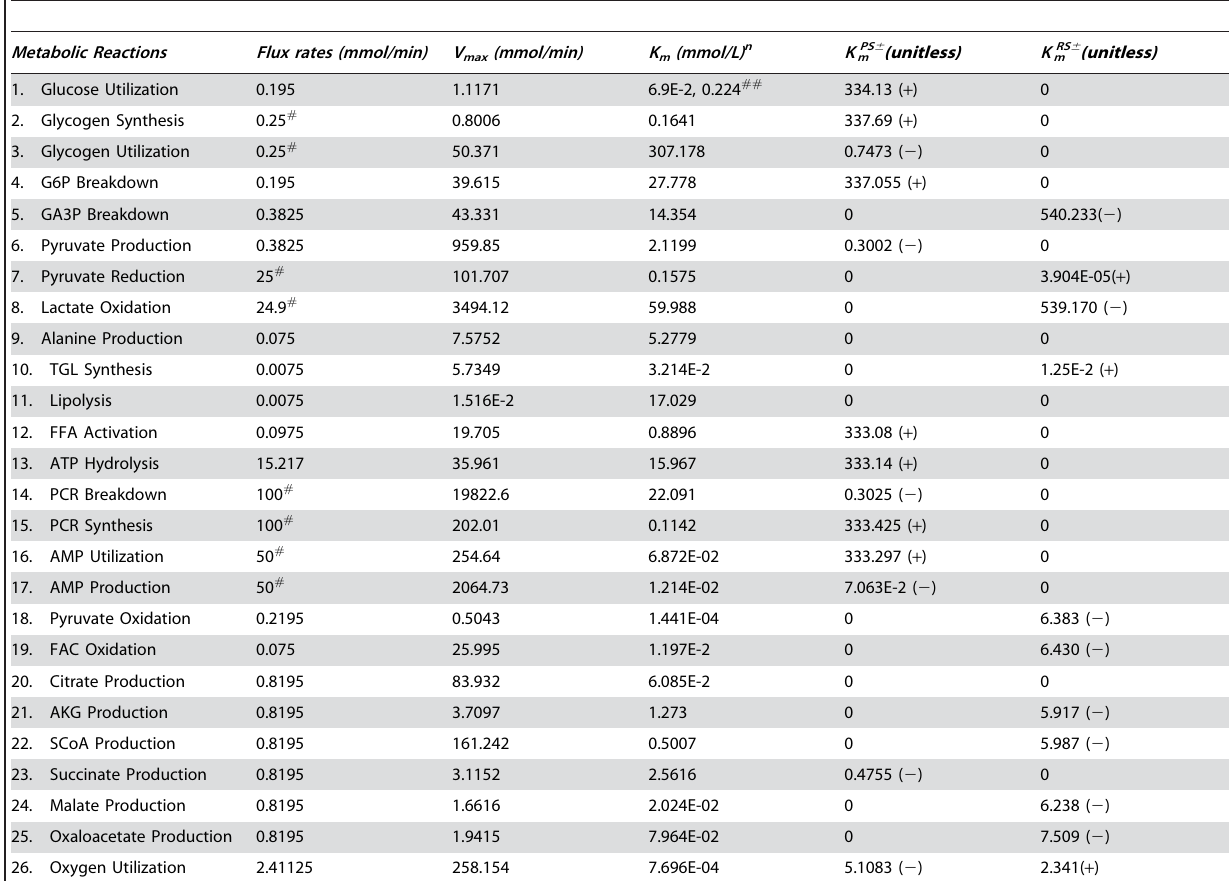
Table 4. Resting, steady-state metabolic reaction flux rates and corresponding optimal estimates of the V max , K m , K PS + K RS + parameters that govern the metabolic reaction flux m